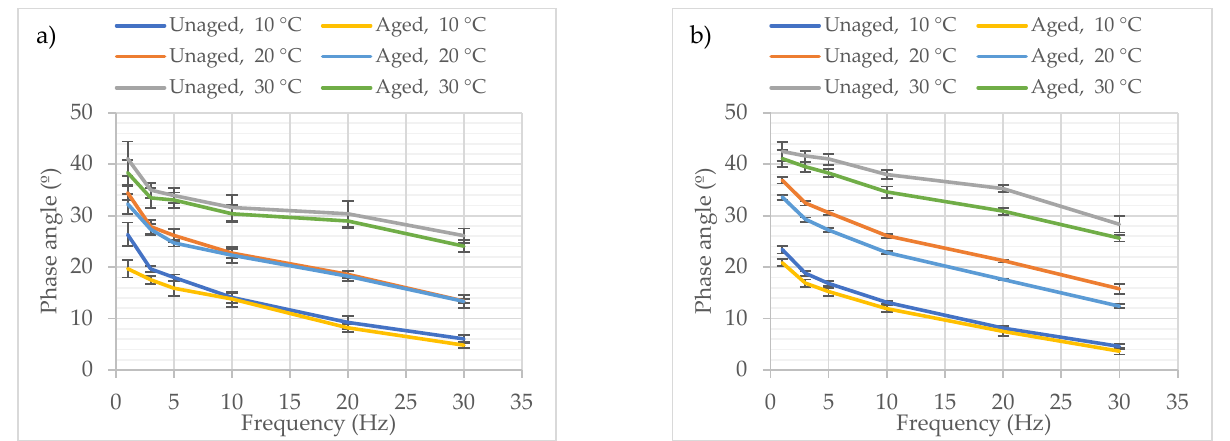
Figure 4. Phase angle of the control ( a ) and modified ( b ) SMA 8 in unaged and aged conditions.